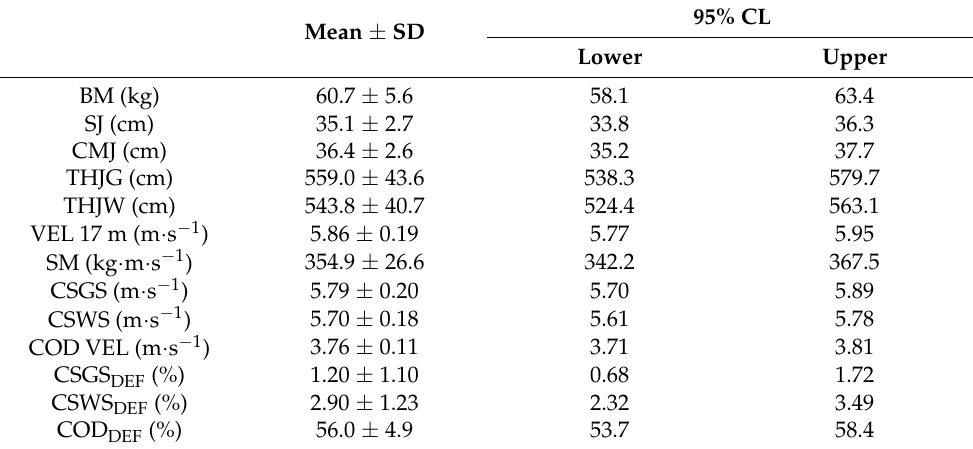
Table 1. Descriptive data of the tested variables.